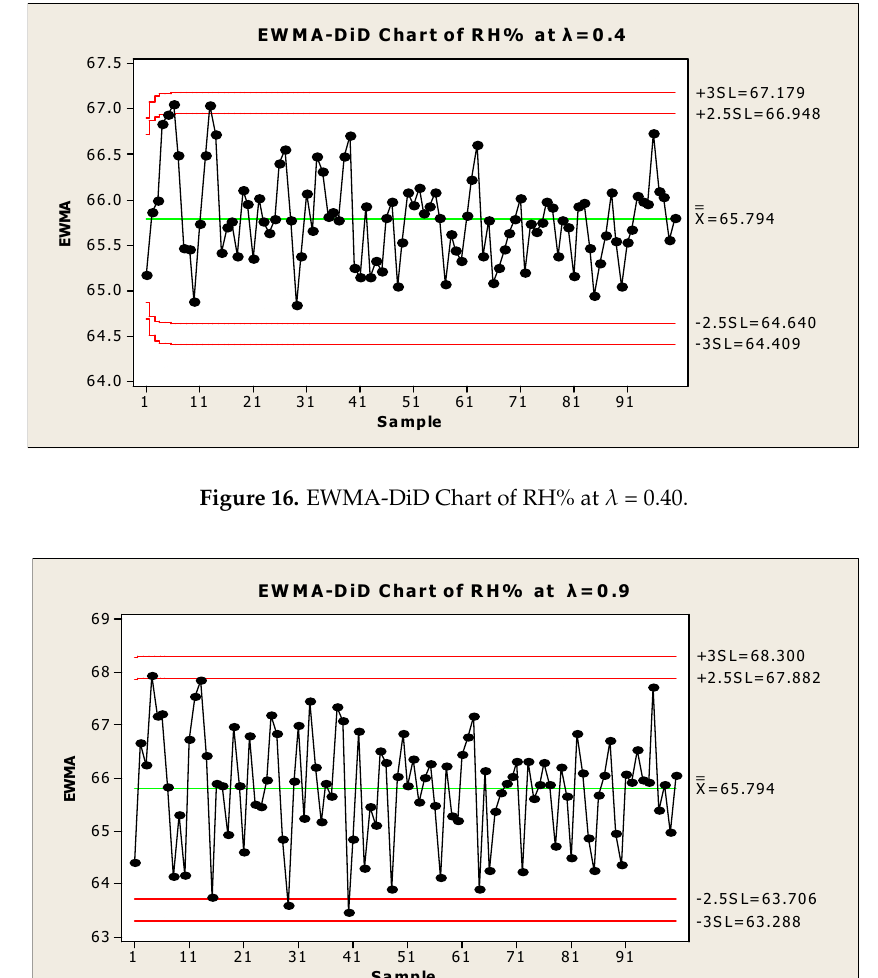
Figure 17. EWMA-DiD Chart of RH% at λ = 0.90.